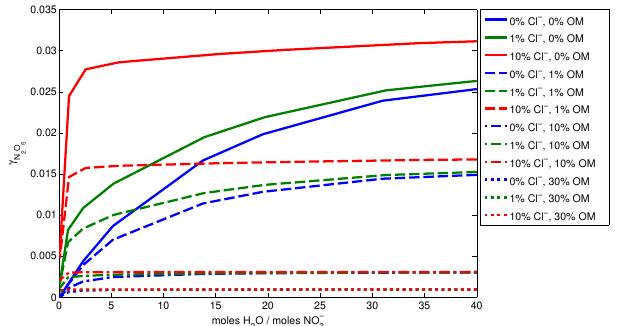
for a 1µm diam- Figure 1. The composition dependence of γ N 2 O 5 eter particle, using the inorganic parameterisation of Bertram and Thornton (2009) combined with the organic coating parameterisa- tion of Riemer et al. (2009). For a range of H 2 O:NO − mole ratios, 3 the γ N for totally inorganic particles with a mole content of chlo- 2 O 5 ride ions of 0, 1, and 10% is represented by the solid blue, green, and red lines, respectively. The suppression of γ N for these different 2 O 5 inorganic particle compositions by an organic shell comprising 1, 10, and 30% of the total particle mass is indicated by the dashed, dash-dotted, and dotted lines,